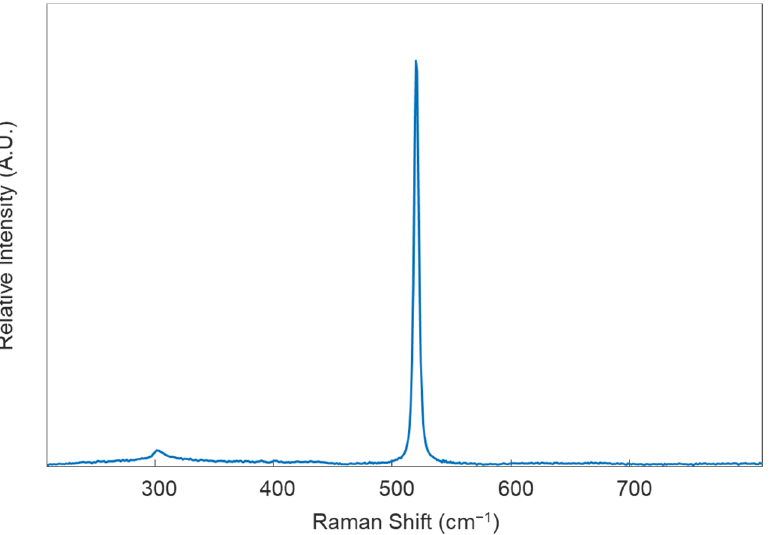
Figure 2. Example Raman spectrum of a silicon standard obtained under excitation using a 785 nm diode laser.